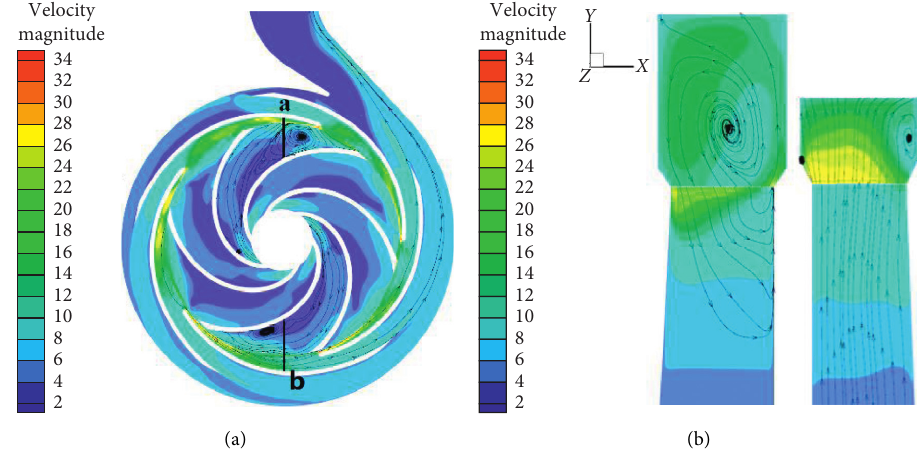
Figure 10: Midsection and axial surface streamline of impeller under part-load